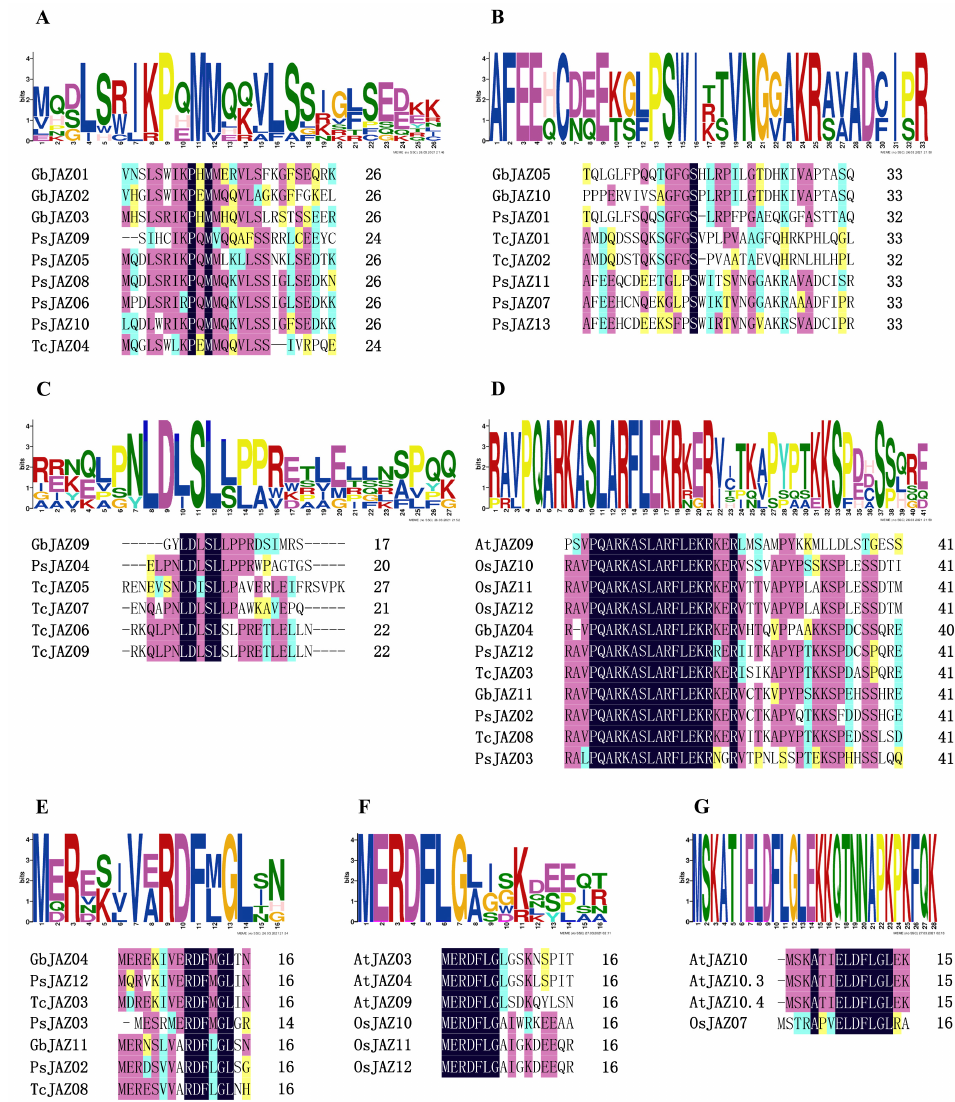
Figure 6. Specific motifs model and sequences alignment. ( A ) PxMMx3LS-motif; ( B ) (A/T)(F/M)EE x6G(L/F)(P/G)S-motif; ( C ) LDLSLx-motif; ( D ) AVPQARK-motif; ( E ) V(E/A)RDF(L/M)GL-motif; x6G(L/F)(P/G)S-motif; ( C ) LDLSLx-motif; ( D ) AVPQARK-motif; V(E/A)RDF(L/M)GL-motif; ( F ) ( F ) MERDFLG-motif; ( G ) MERDFLG-motif; ( G ) ELDFLGL-motif.